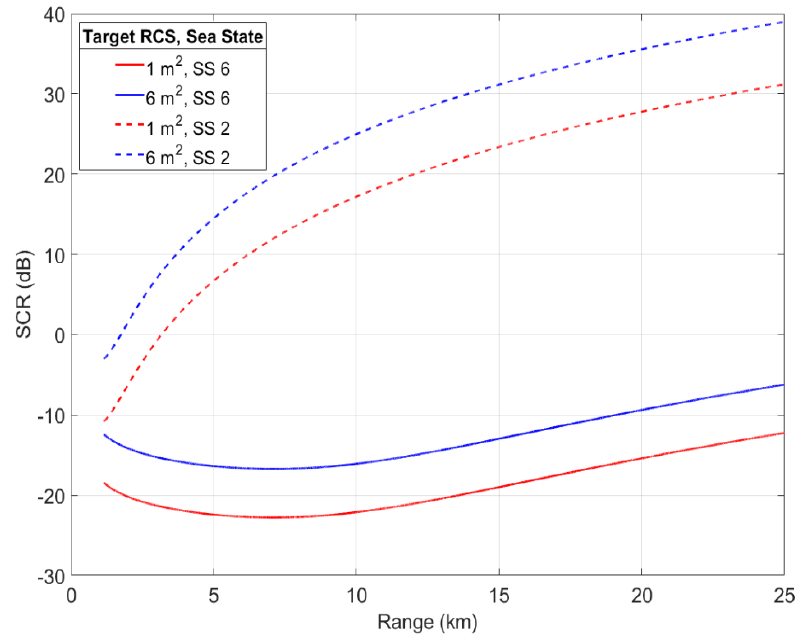
Figure 10. Simulation of signal-to-clutter ratio versus detection range.